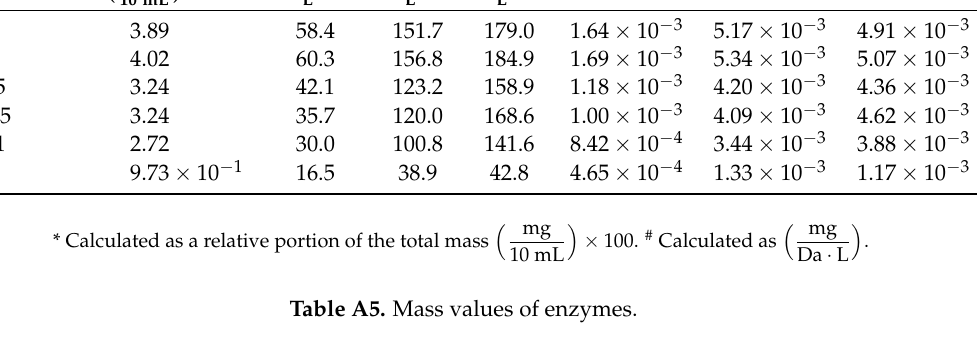
Table A4. Mass and molar concentration of enzymes in cell-free extract from Experiment 2. IPTG